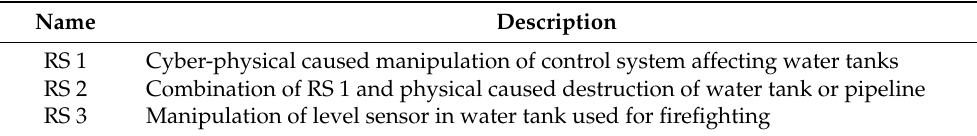
Table 1. Summary of risk scenarios (RSs) selected by the water utility for the RAET demonstration.